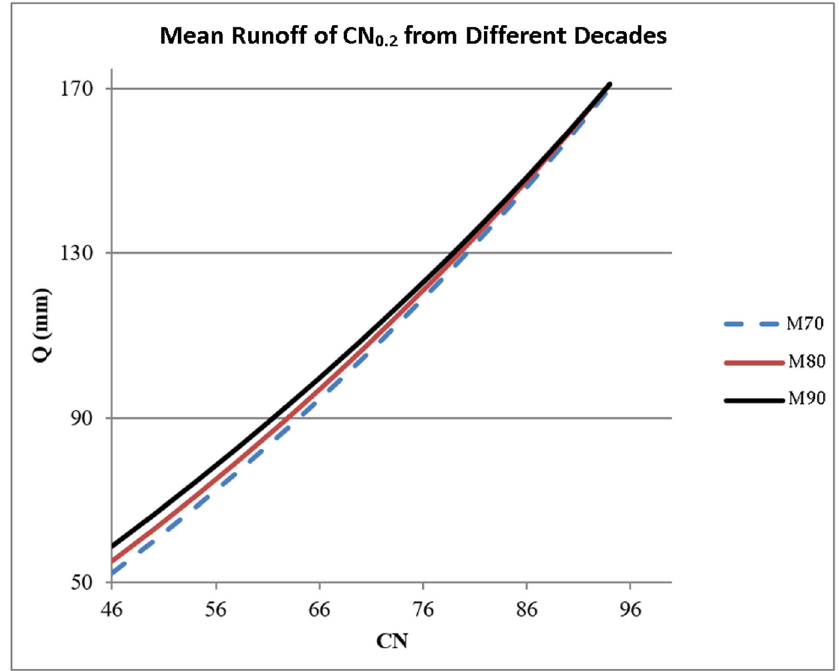
Figure 5. Mean runo ff (mm) of decadal datasets of M70, M80, and M90 for selected CN 0.2